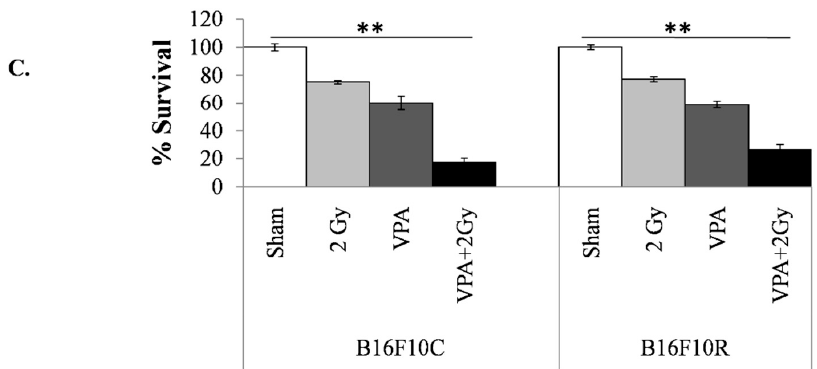
Figure 4. Survival assay for parental melanoma cells (B16F10C) and drug-resistant melanoma cells (B16F10R).Cells were pretreated with an IC 25 dose of VPA (IC 25 ) and incubated for 24 h. After irradiation with 2 Gy, cells were further incubated with drugs for 24 h. The cells were trypsinized and platted (300 cells/dish) and incubated for 12–15 days. The colonies in control B16F10C ( A ) and drug-resistant B16F10R ( B ) were counted and respective % survival was calculated with the sham considered as 100% and plotted in ( C ). % survival = (number of colonies in treated plate/number of colonies in untreated plate) × 100. ** p > 0.001.